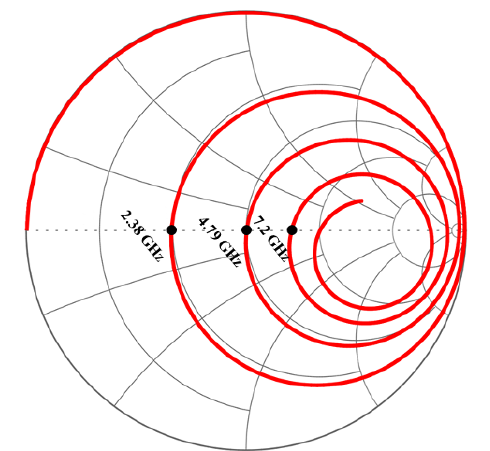
Figure 10. Comparison of simulations and equivalent circuit results in different d = ( a ) 0.5, ( b ) 1, ( c ) 1.5, ( d ) 1.9 mm.